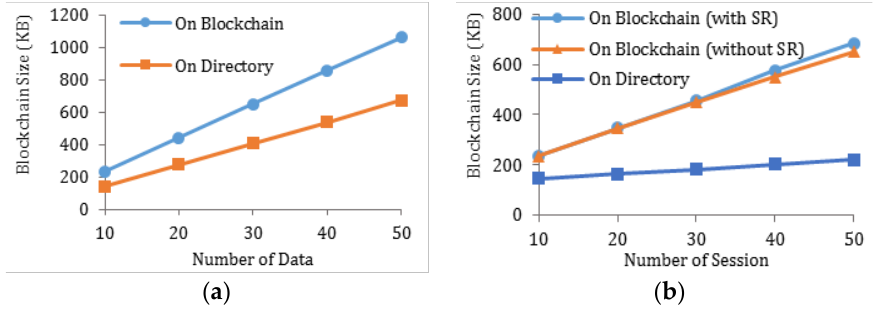
Figure 10. Study the communication overhead of MedChain by comparing the mutable information storage on blockchain with the storage on the directory in ( a ) different numbers of data generated per session and ( b ) different numbers of sessions with 10 medical records to share per session.